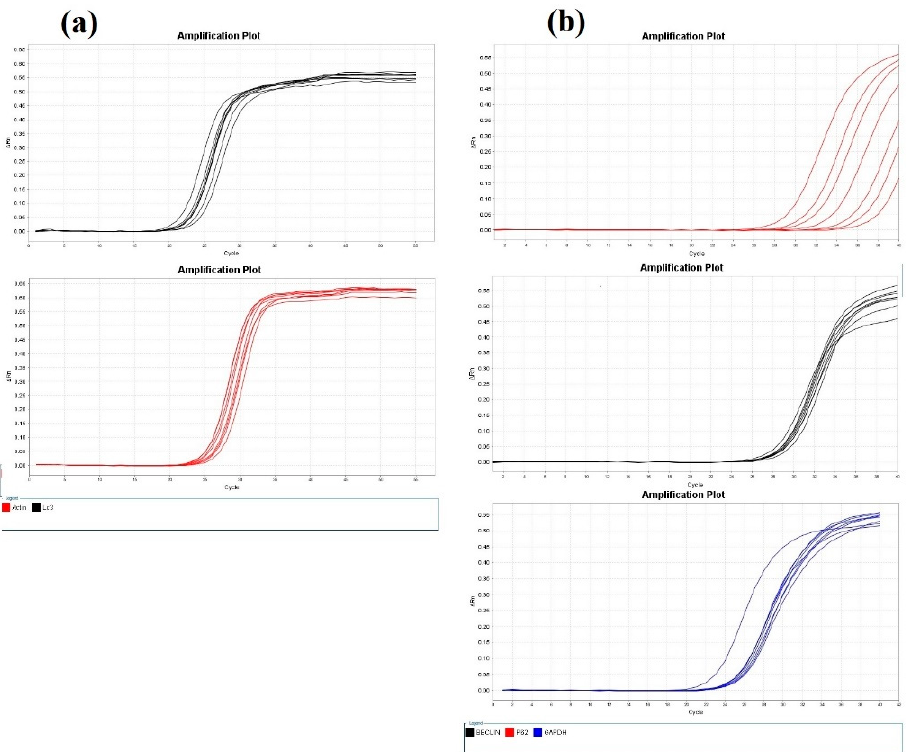
Figure 7. ( a ) Amplification plots of LC3-II and β –actin mRNA gene expression; ( b ) amplification plots of BECN1, p62, and GADPH mRNA gene expression.